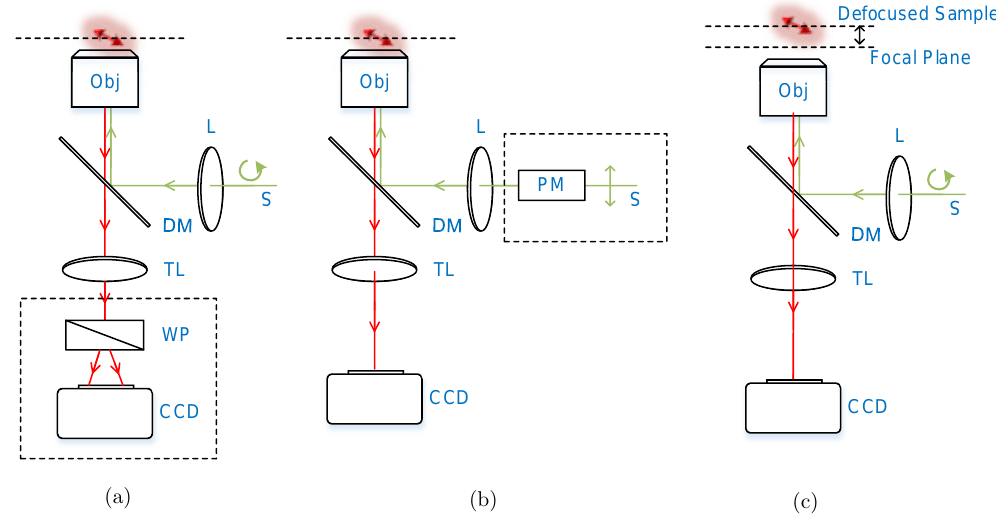
Fig. 2. Schematic setup of di®erent types of FPM. (a) A typical setup of FA. Circularly polarized light source is used, with either epi-illumination (displayed in the ¯gure) or confocal illumination (together with point detectors, not displayed). Wollaston Prism (WP) could allow simultaneous detection of two polarization channels utilizing two halves of the camera. (b) A typical setup of linear dichroism (LD). The linearly polarized light source passes a polarization modulator (PM), resulting in varying polarizations of excitation light. The time trace images of °uorescence intensity changing with the excitation polarization would be recorded. Both epi-illumination or confocal illumination could be used and the polarization modulator could be a rotary half wave plate, an electro- optical modulator, etc. (c) A typical setup of defocused pattern recognition (DPR). The sample is usually defocused with several hundred nanometers away from the focal plane of the objective. The di®raction pattern of the dipoles would be recorded and be used for orientation measurement. Circularly polarized light source is used for e®ective excitation of all the